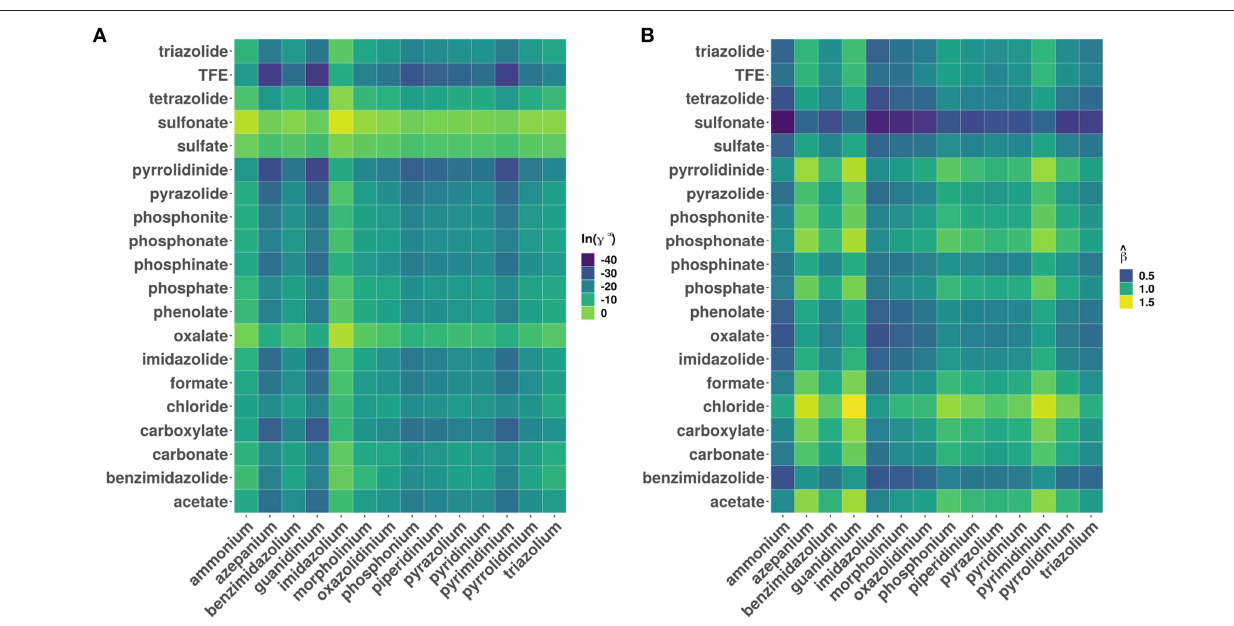
FIGURE 4 | Heatmaps showing the distribution of (A) logarithm of infinite dilution activity coefficients ( ln γ ∞ ) of multicrystalline cellulose in various ionic liquids and (B) predicted hydrogen bond bascities ( ˆ β ). The data has been grouped according to different cation and anion